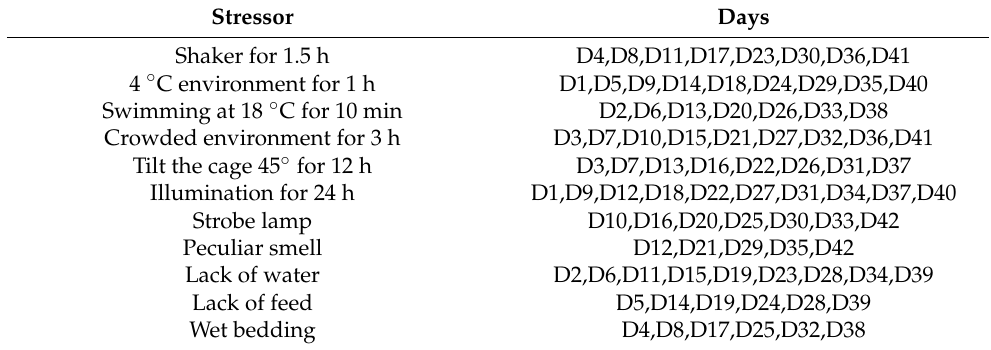
Table 1. Chronic unpredictable mild stress procedure. Dx (x = 1, 2, . . . 45) indicates day X.